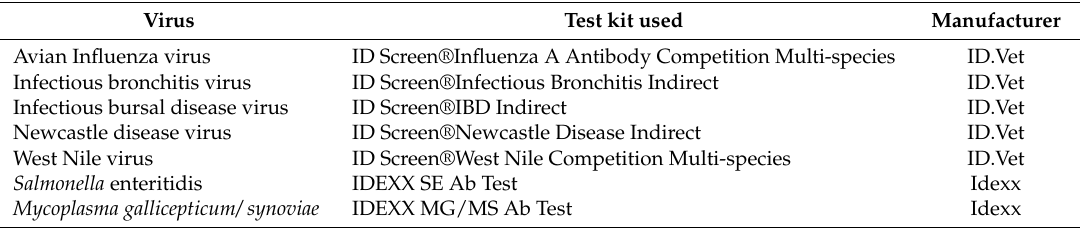
Table 1. ELISA kits used to detect antibodies against various backyard poultry